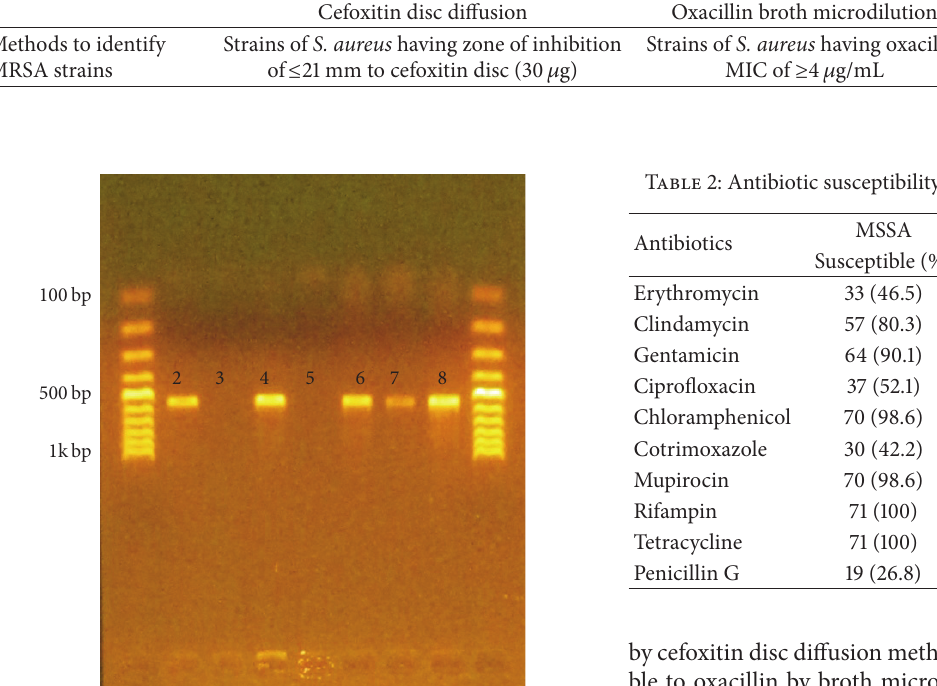
Figure 1: Gel electrophoresis showing the PCR products (lane 1 and lane 9: DNA ladder, lane 2: positive control, lane 3: negative control,